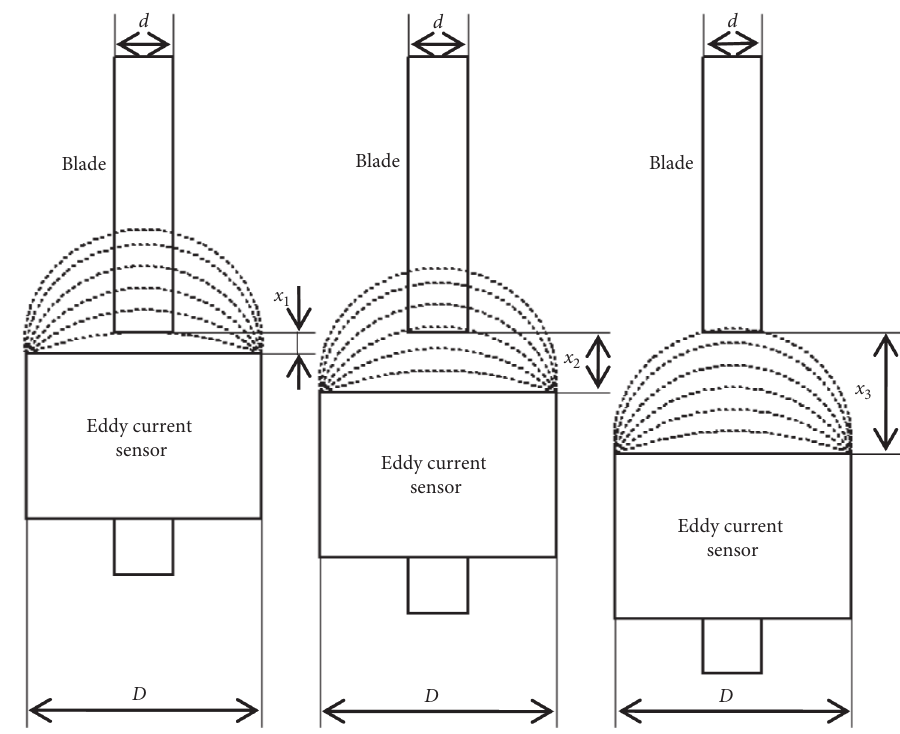
Figure 4: Macroscopic process of blade static radial